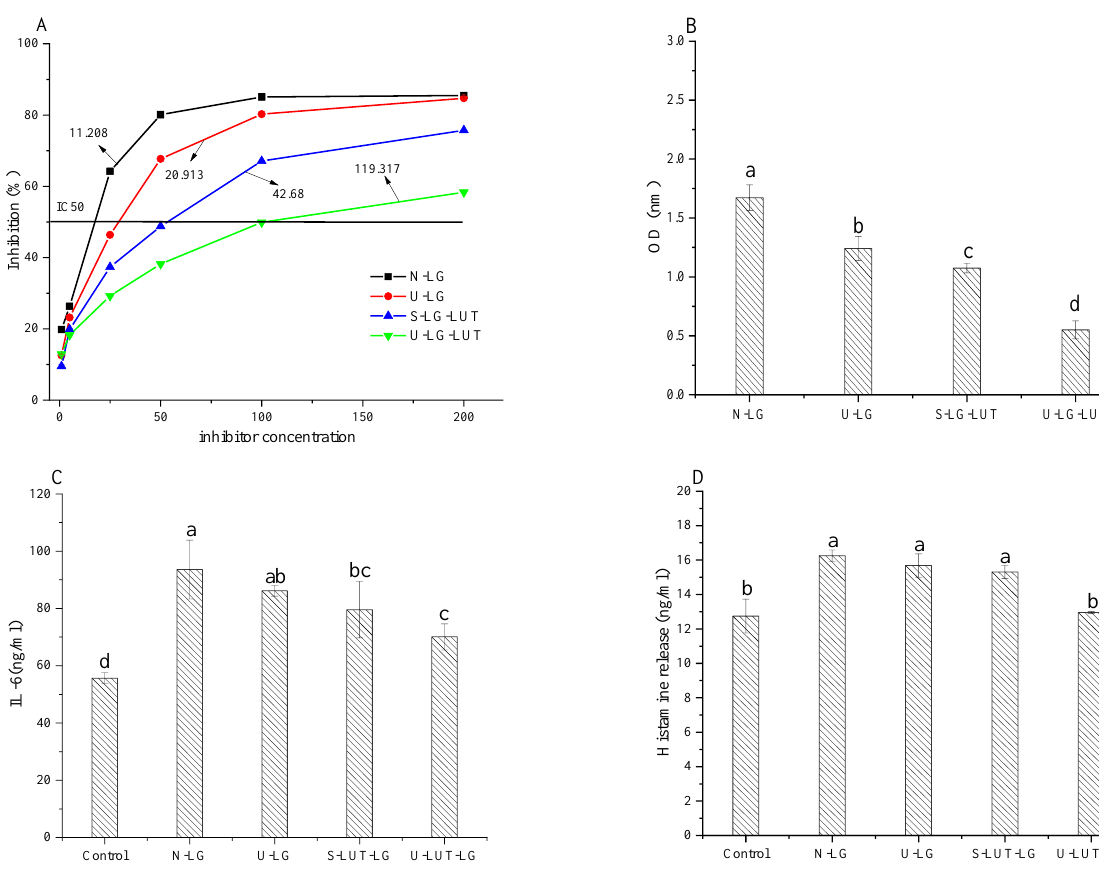
Figure 3. IgG ( A) and IgE ( B ) binding ability, and the release of IL-6 ( C ) and histamine ( D ) of N-LG, U-LG, S-LG–LUT and U-LG–LUT. Letters (a–d) in the figure body mean significantly different ( p < 0.05).